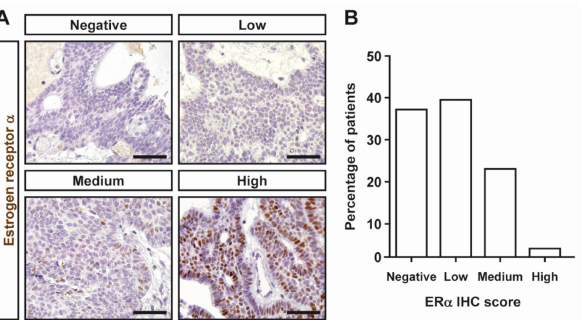
Figure 1. Immunohistochemical detection of estrogen receptor α (ER α ) in CPs assessed by immuno- histochemistry. ( A ) Representative pictures of ER α immunohistochemical categories in CPs. Negative, no or only cytoplasmic immunoreactivity, IRS 0–1; low, IRS 2–3; medium, IRS 4–8; and high, IRS 9–12. Scale bar: 50 µ m. ( B ) Percentage of patients with CPs for IHC